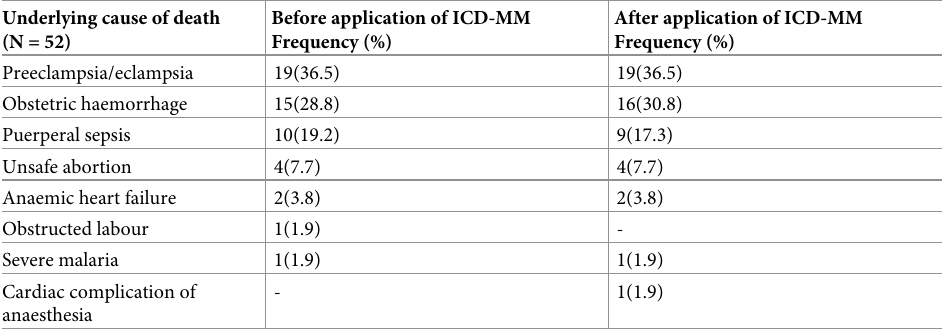
Table 2. Underlying causes of death before and after application of WHO ICD-MM classification among cases of maternal death at University of Abuja Teaching Hospital, Abuja, Nigeria, 2014–2018 (n = 52). Underlying cause of death (N =